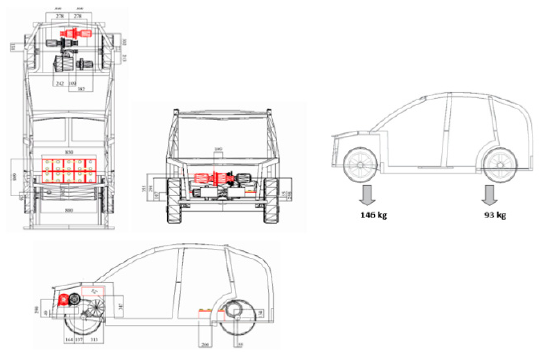
Figure 14. Example of Components Packaging and Weight Distribution in a City Car.